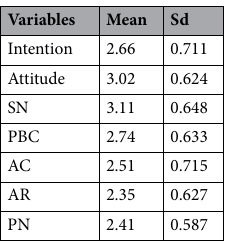
Table 2. Descriptive statistics of observed variables.